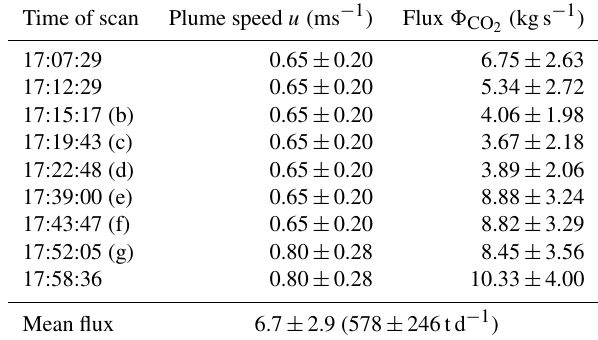
Table 1. Start of the scans performed (local time), the vertical plume speed components with uncertainties (Student t deviation), and the corresponding CO 2 fluxes with uncertainties (1 SD). Those profiles shown in Fig. 2 have their panel identifier written after the